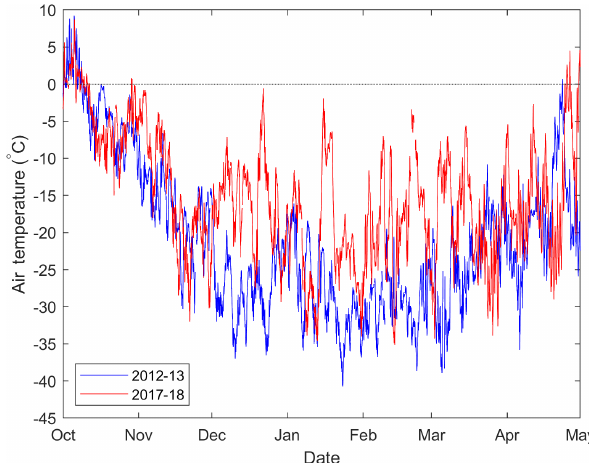
Figure 4. Air temperature at Trail Valley Creek during winter 2012– 2013 and